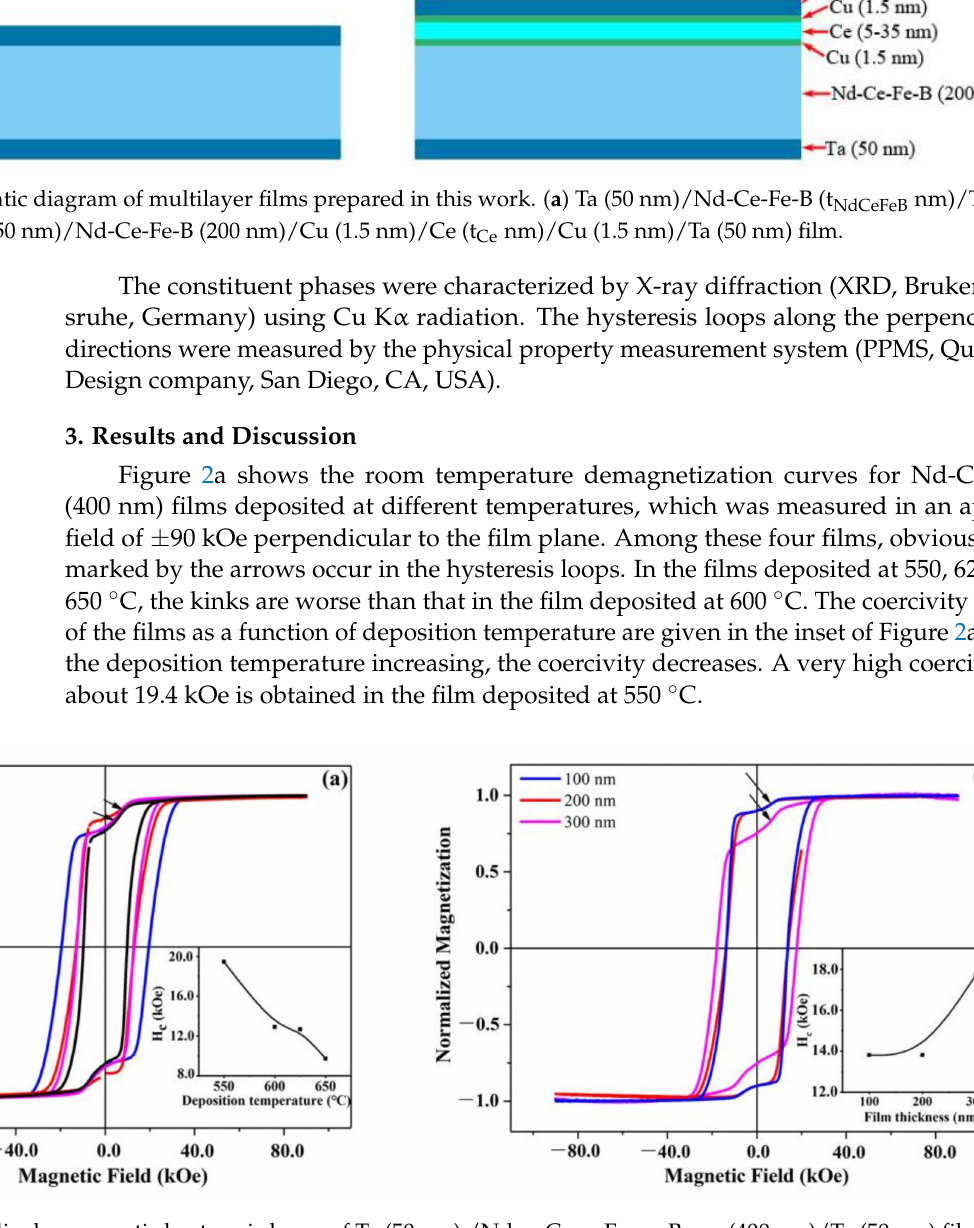
Figure 2. ( a ) Perpendicular magnetic hysteresis loops of Ta (50 nm) /Nd 6.19 Ce 7.98 Fe 75.48 B 10.35 (400 nm)/Ta (50 nm) films deposited at different temperatures with the corresponding coercivity values in the inset. ( b ) Perpendicular magnetic hysteresis loops of Ta(50 nm)/Nd 6.19 Ce 7.98 Fe 75.48 B 10.35 (t Nd-Ce-Fe-B nm)/Ta (50 nm) films with different Nd-Ce-Fe-B layer thicknesses (t Nd-Ce-Fe-B = 100, 200, 300), and the corresponding coercivity values were shown in the inset.